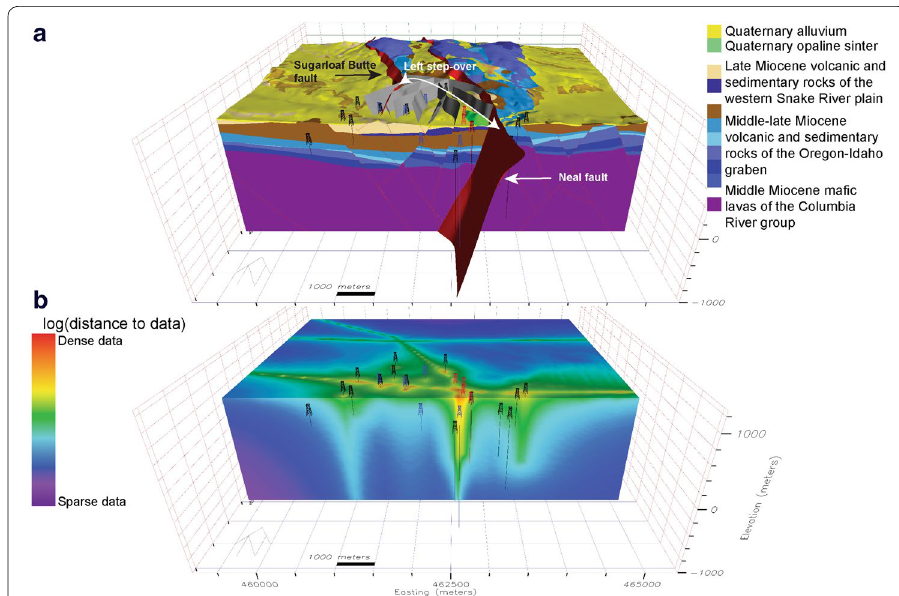
Fig. 8 a 3D geologic map of the Neal Hot Springs geothermal field. View direction is to the north. Quaternary opaline silica sinter is show in green. Fluid upwelling (red wells are production wells) is interpreted to be controlled by a left step-over (or relay ramp) between two west-dipping normal faults, the Neal fault to the east and the Sugarloaf Butte fault to the west (both in red), and the associated high-density faulting within the step-over (gray faults). b 3D model of logarithm of distance to input data (lithologic data along wells, surficial geophysical and 2D geologic map data, and 2D geologic cross sections and seismic reflection profiles) to the Neal model. Cross section shown, sliced east–west though the geothermal field is the same as a . High data density in the Neal step-over suggests that the 3D geologic relationships in this area are well constrained relative to areas of sparse